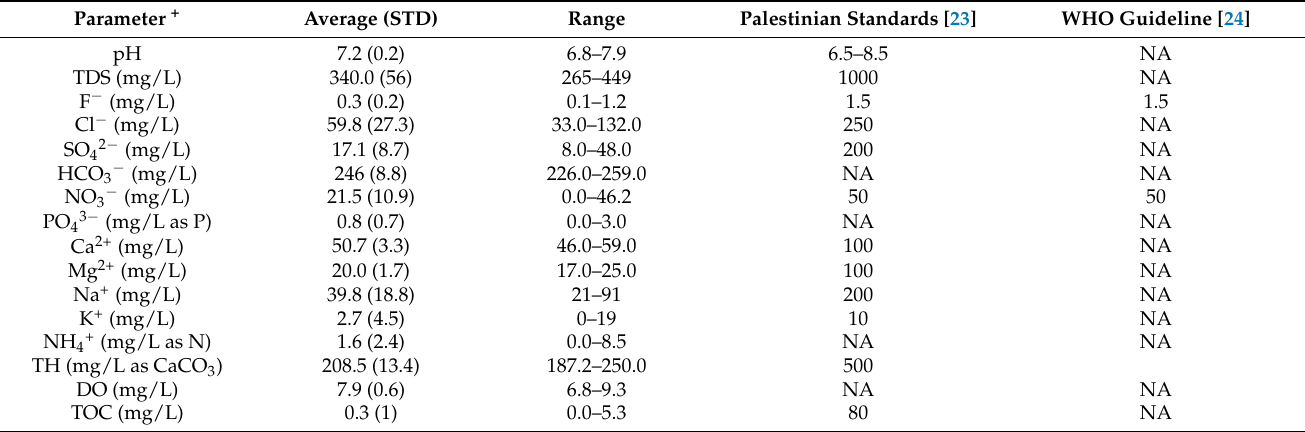
Table 1. Physicochemical parameters of the groundwater from 29 wells in the West Bank,